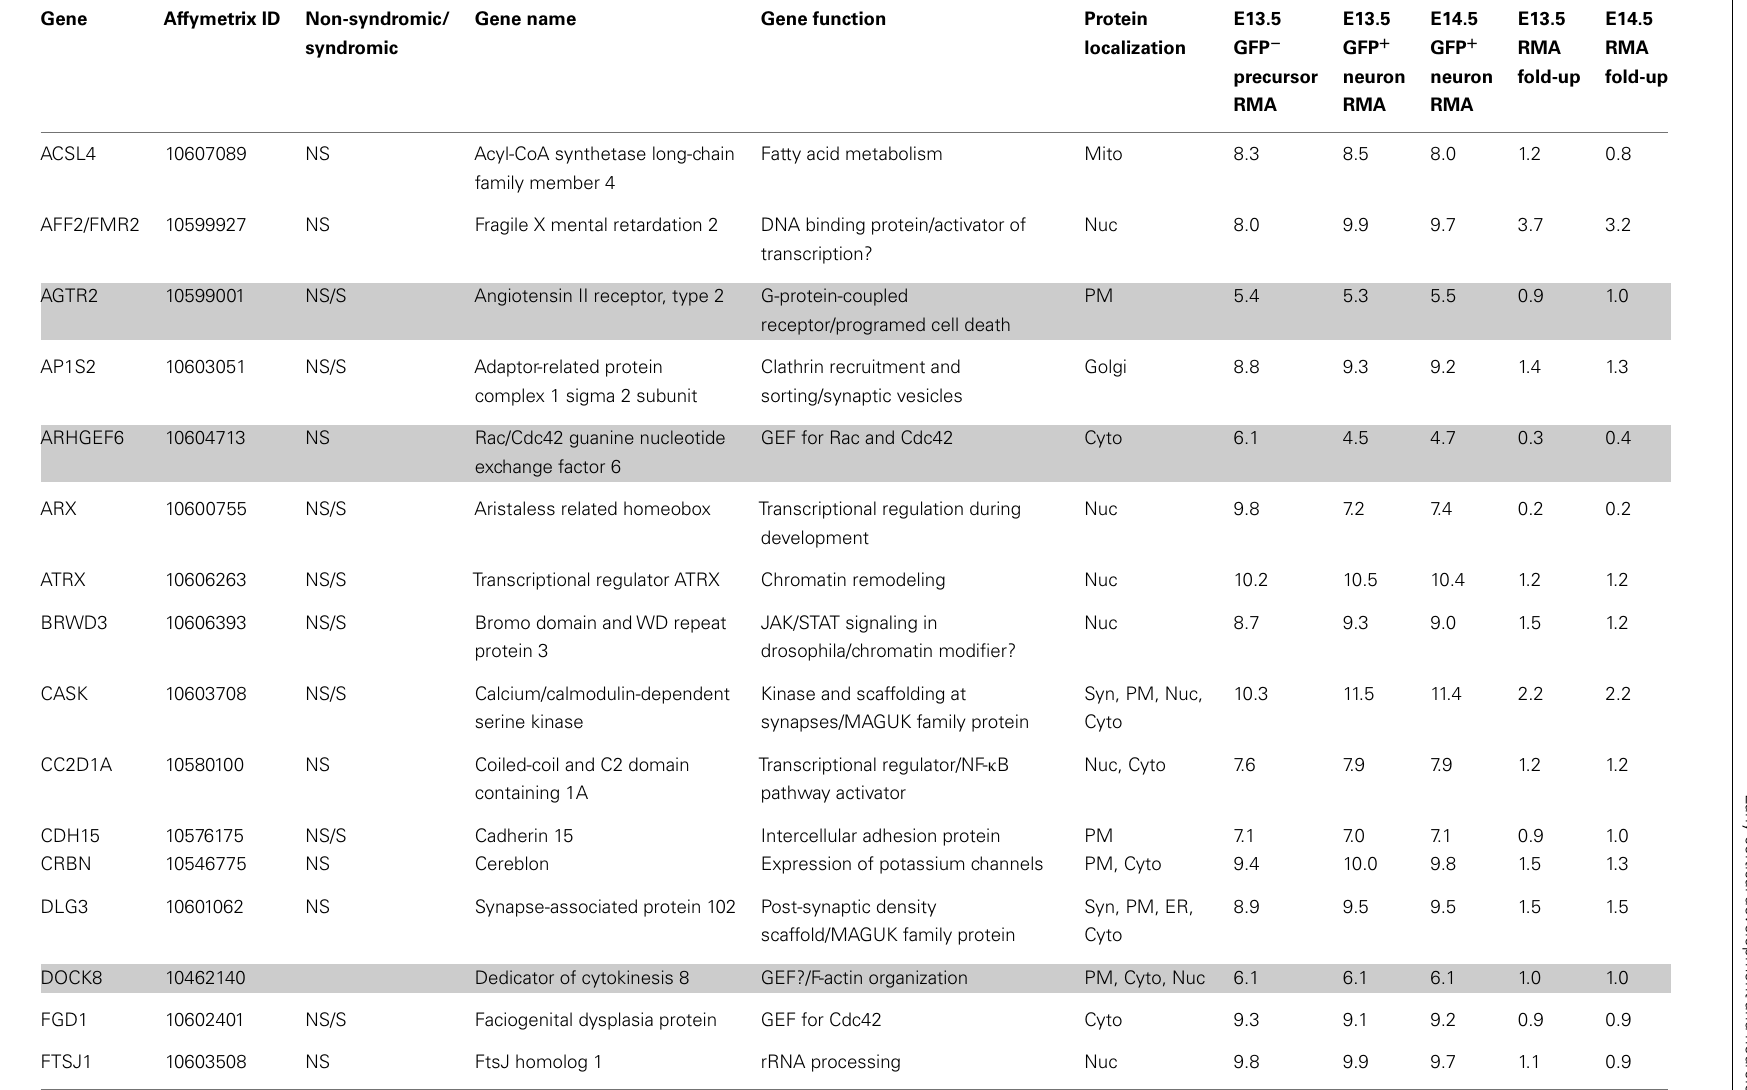
Table 1 | List of non-syndromic intellectual disability (NS-ID) genes expressed in immature excitatory neurons . Gene Affymetrix ID Non-syndromic/